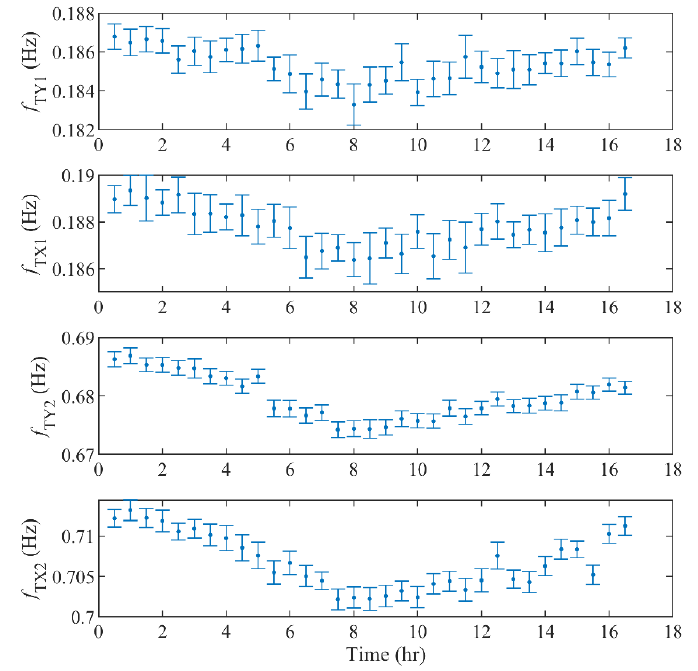
Figure 11. Time history of the identified frequency.